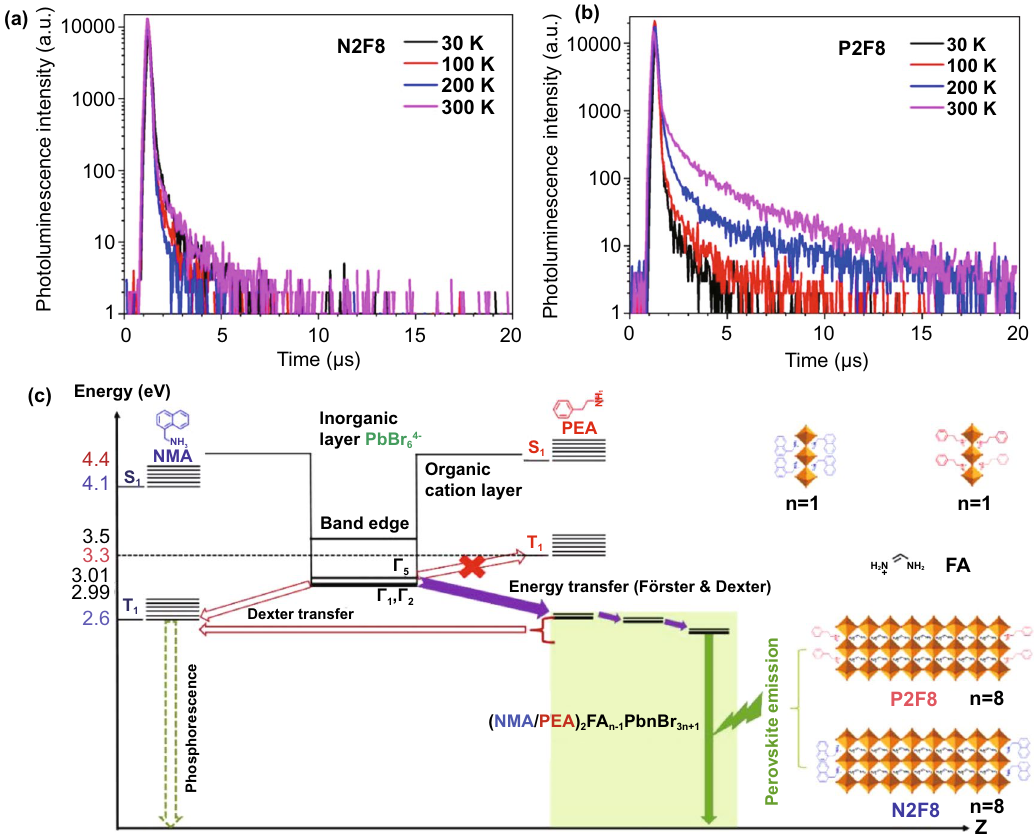
Fig. 11 Photoluminescence decay curves of a N2F8 and b P2F8. c Energy transfer mechanism of quasi-2D perovskites under light excitation. Where S is the singlet state and is the triplet states. Copyright 2019 Springer Nature